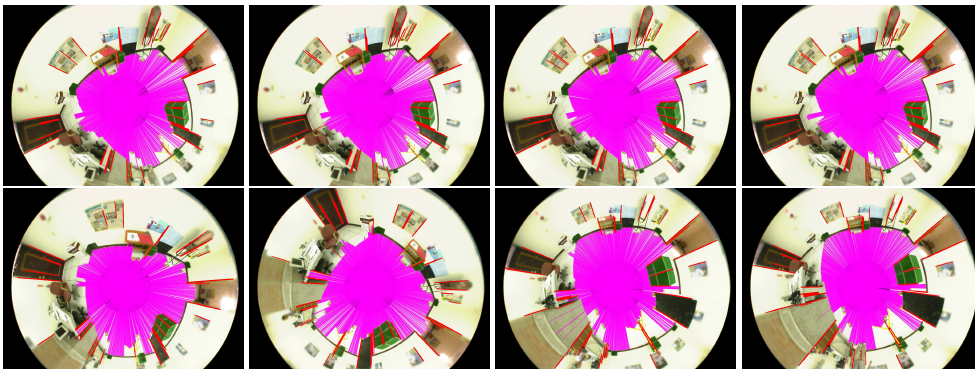
Figure 12. The ground plane segmentation and vertical line identification from an acquired om- nidirectional image sequence. It can be seen that the ground region extraction is relatively stable compared to the line segment detection.